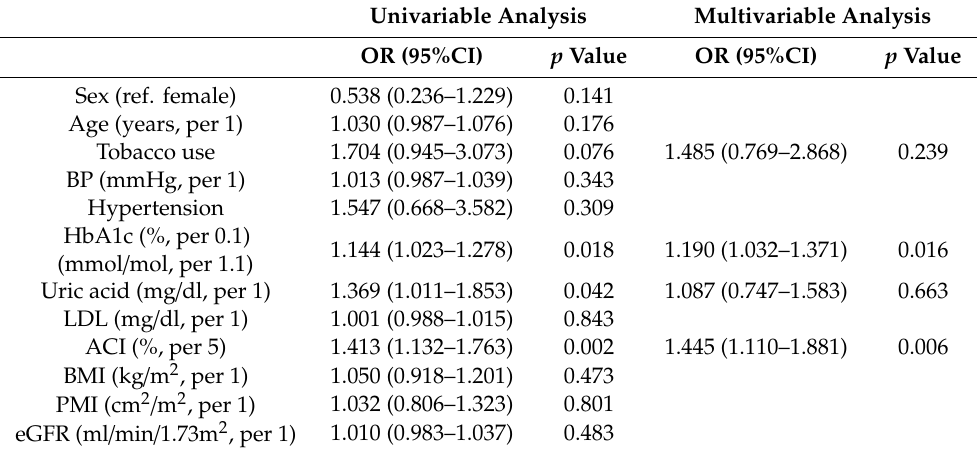
Table 2. Independent predictors associated with pre-existing histopathological damages.